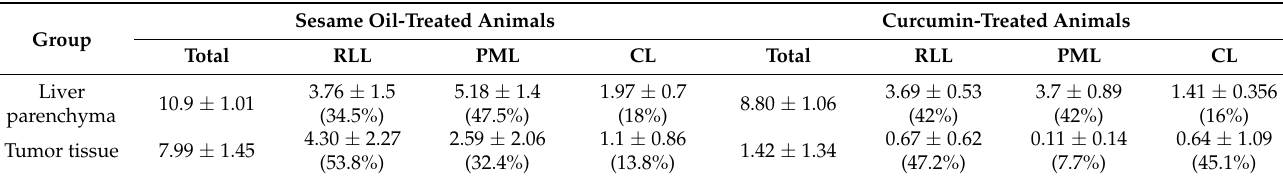
Table 1. Total liver parenchymal and tumor tissue volume values, as well as detailed values for the right lateral lobe (RLL), paramedian lobe (PML), and caudate lobes (CL) (cm 3 ) are expressed as mean and standard deviation. The figure in brackets expresses the percentage of each lobe relative to the total mass of the liver or tumor, depending on the tissue type. Sesame Oil-Treated Animals Curcumin-Treated Animals Group Total RLL PML CL CL Liver parenchyma Tumor